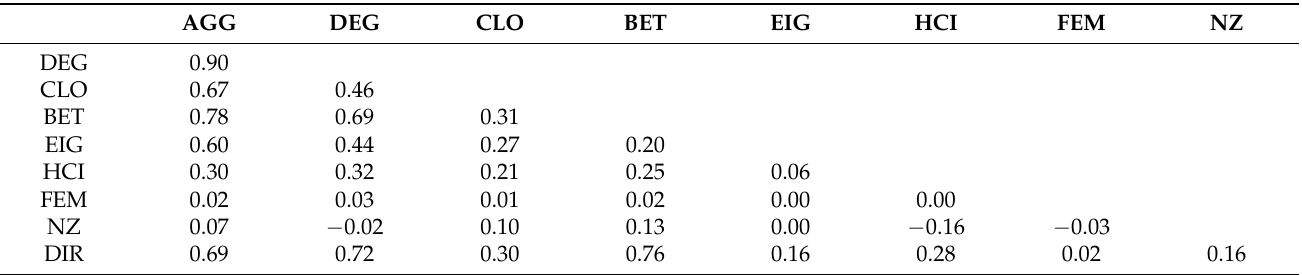
Table 2. Pearson pairwise